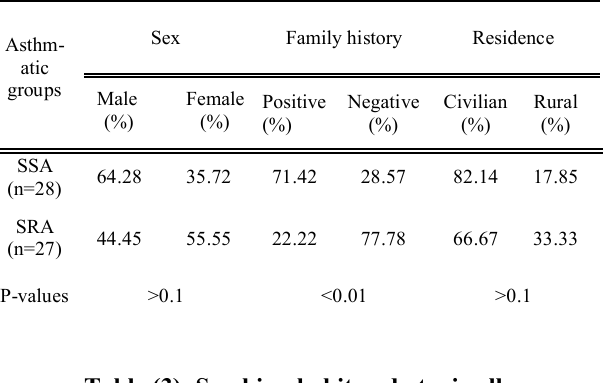
Table (2): Sex distribution, family history and residence among SRA and SSA patients included in the study.